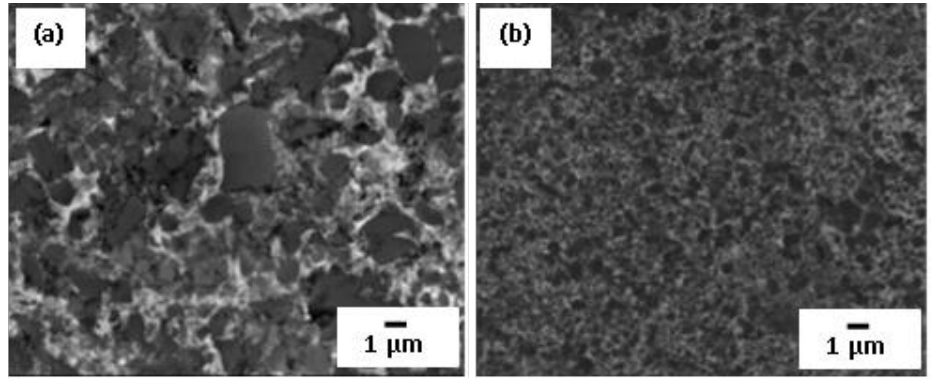
Figure 11. SEM microstructure for TiB 2 -Cu composites: ( a ) 70 vol.% TiB 2 , and ( b ) 45 vol.% TiB 2 . Reprinted from Ziemnicka-Sylwester et al., 2014 with copyright permission, Materials & Design [72].